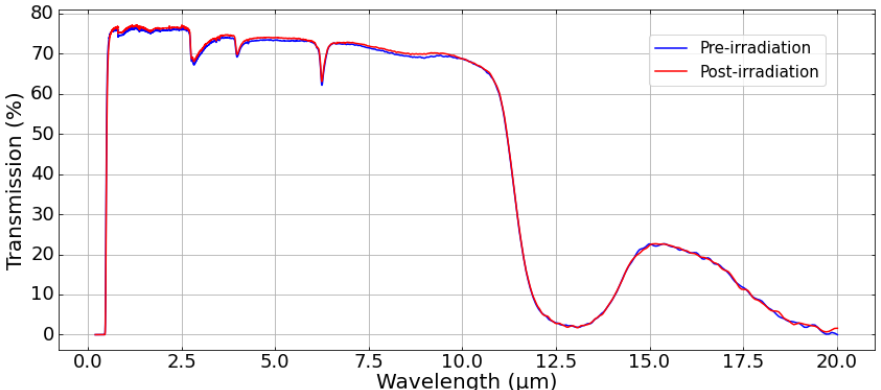
Figure 8. Spectral transmission in Vis–IR range before and after writing a 1.5 mm diameter homogenous disk with a fixed phase variation of π rad in the 75 ( GeS 2 ) − 15 ( In 2 S 3 ) − 10 ( CsCl ) glass material. Parameters: 1030 nm, 800 fs, 100 kHz, 0.6 NA, 1 mm/s, 0.05 µJ.